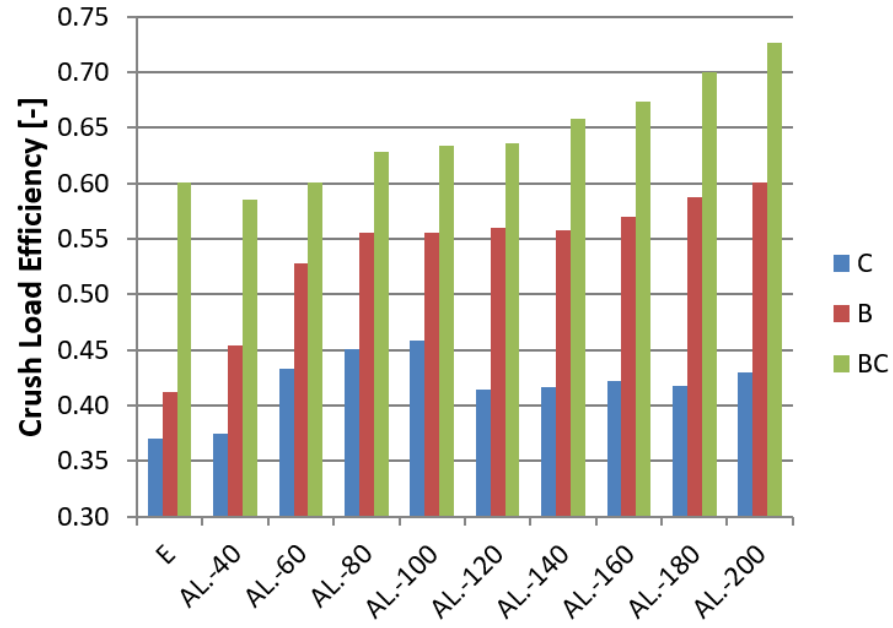
Figure 16. CLE indicator for all tested absorbers.